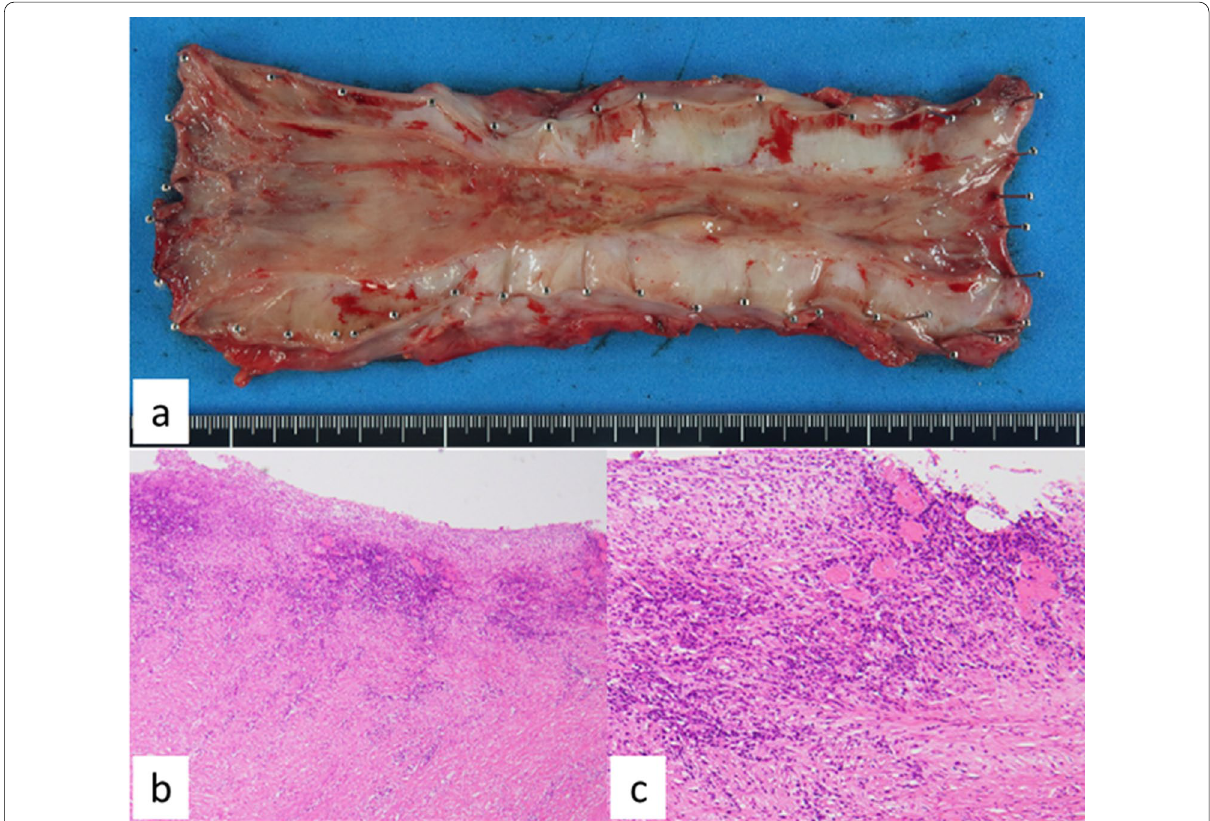
Fig. 4 Resected specimen of the esophagus. a There is no apparent tumor on gross examination. b , c There are no malignant variable cells in the pathological findings, although inflammatory cells invade the superficial area. c Shows high-power magnification